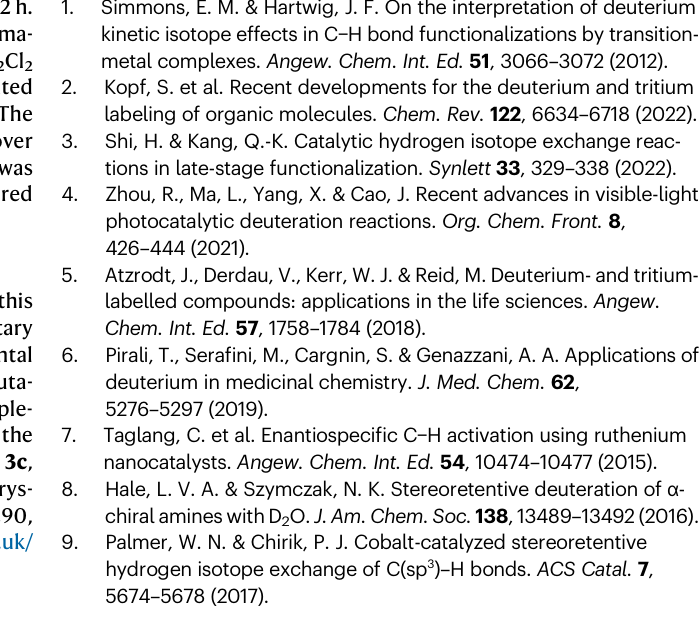
non-covalentinteractions(NCI),anddistortion/interactionanalyses.Energiesarein kcal/mol and distances are in Å. See Supplementary Note 2.11 for full details.